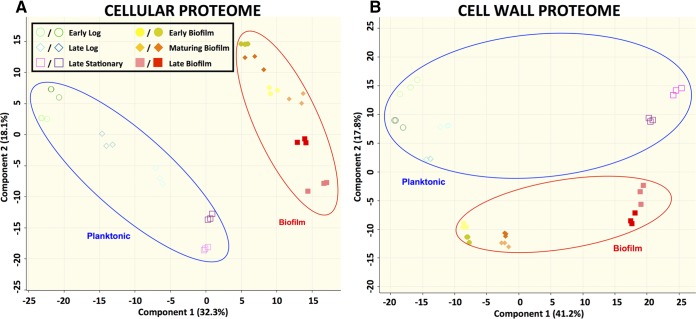
Clustering of biofilm and planktonic samples based on proteomic data. Data represent results of principal-component analysis (PCA) of log2 LFQ intensity values from each sample in either the cellular proteome (A) or the cell wall proteome (B). The PCA plot represents 532 proteins (cellular proteome) or 489 proteins (cell wall proteome) for which expression values were available. Technical triplicates are shown by matching symbols and colors. Biological duplicates are shown by matching symbols.